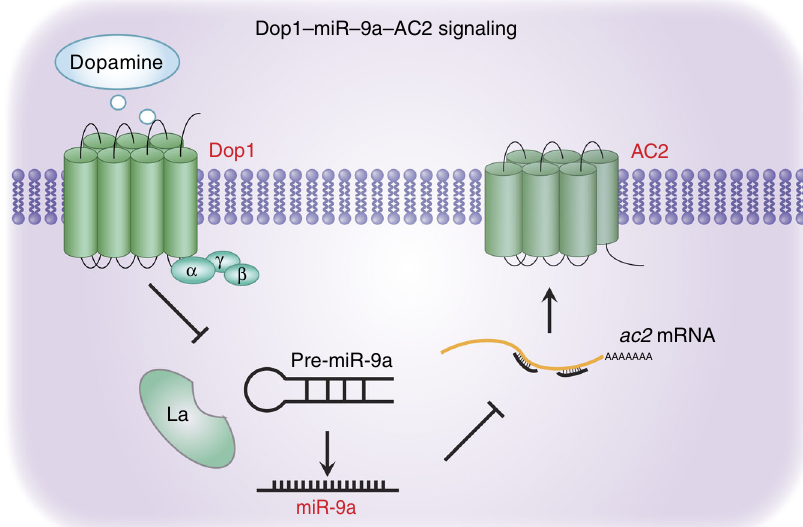
Fig. 9 A model for Dop1 modulating AC2 expression through mediating the maturation of miR-9a. After binding to dopamine, Dop1 induces the disassociation of the La protein from pre-miR-9a and then the decrease in miR-9a expression. The downregulation of miR-9a abolishes its inhibiting effects on ac2 and upregulates AC2 expression. The increase in AC2 fi nally induces locust olfactory preference for gregarious